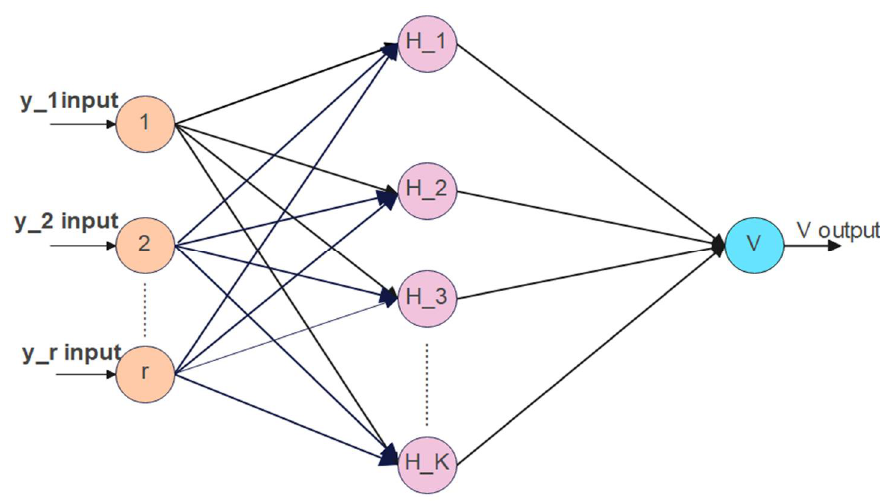
Figure 1. Extreme learning machine architecture. ELM